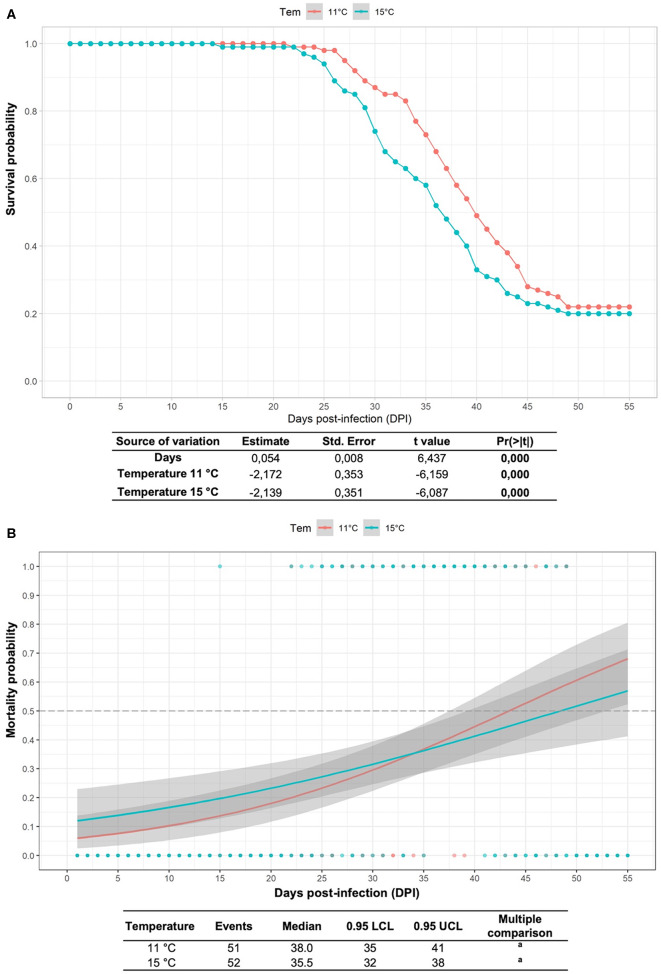
Survival study and mortality probability model in Atlantic salmon pre-smolts infected with R. salmoninarum. (A) Kaplan-Meier estimator of the cumulative survival function for fish infected with R. salmoninarum at 11 and 15°C considering three replicates. The green and red shaded area represents the 95% confidence interval. (B) Multiple comparison logRank test for mortality probability. The gray shaded area represents the 95% confidence interval. Tem, temperature.